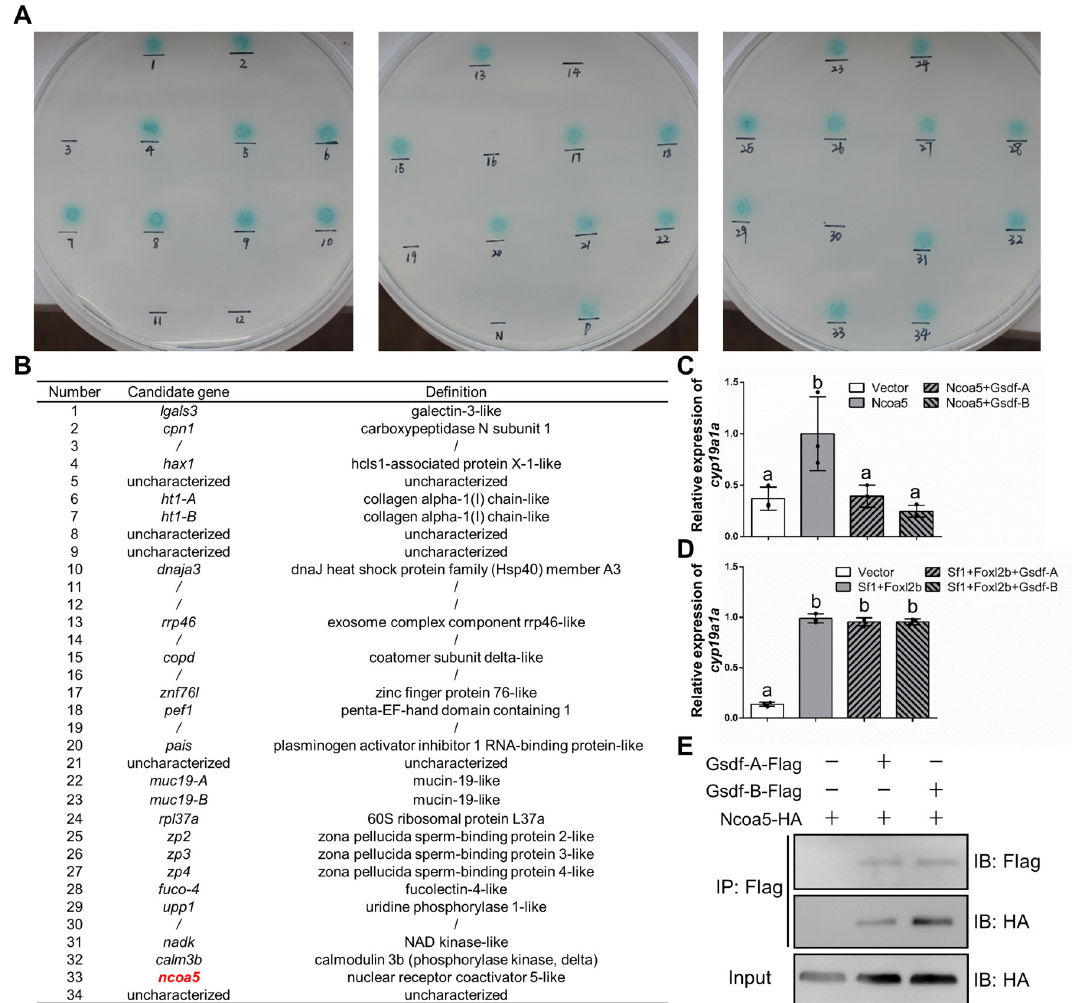
Fig 6. Identification of Gsdf-Ncoa5 interaction via yeast two-hybrid assay and co-immunoprecipitation. (A) Confirmation of 34 candidate interacting proteins of Gsdf-A via yeast two-hybrid assay. +: pGBKT7–53 and pGADT7-T co-transformed as positive control; − : pGBKT7-Lam and pGADT7-T co-transformed as negative control. (B) List of the 27 potential interaction partners of Gsdf-A. (C-D) qPCR analysis of cyp19a1a expression in the CAB cells transfected with different plasmids. Different letters represent statistical differences ( P < 0.01). The highest expression level in each qPCR analysis was used as control and defined as 1. (E) Co-IP of Gsdf-A-Flag and Gsdf-B-Flag with Ncoa5-HA in CAB cells transfected with the indicated plasmids. Anti-Flag Ab was used for Co-IP. Sf1: Sf1-A and Sf1-B; Foxl2b: Foxl2b-A and Foxl2b-B; Ncoa5: